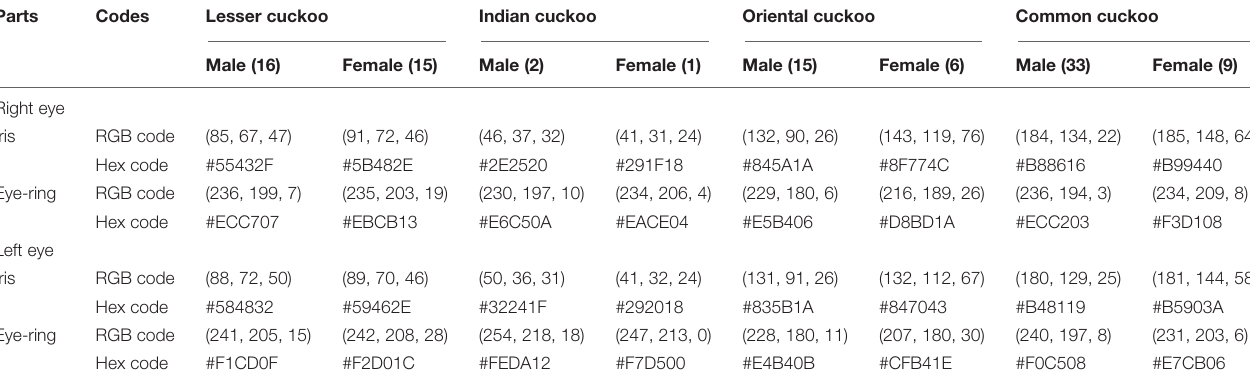
FIGURE 2 | The thickness of underpart barring of males and females of the four Cuculus cuckoos. Each gray open dot represents the thickness of different individuals, for which the thickness of three randomly selected barring were averaged. Black dots with vertical bars indicate mean values with its 95% confidence intervals. TABLE 3 | Eye colors (iris and eye-ring) according to right/left eye, sex and species among the four Cuculus